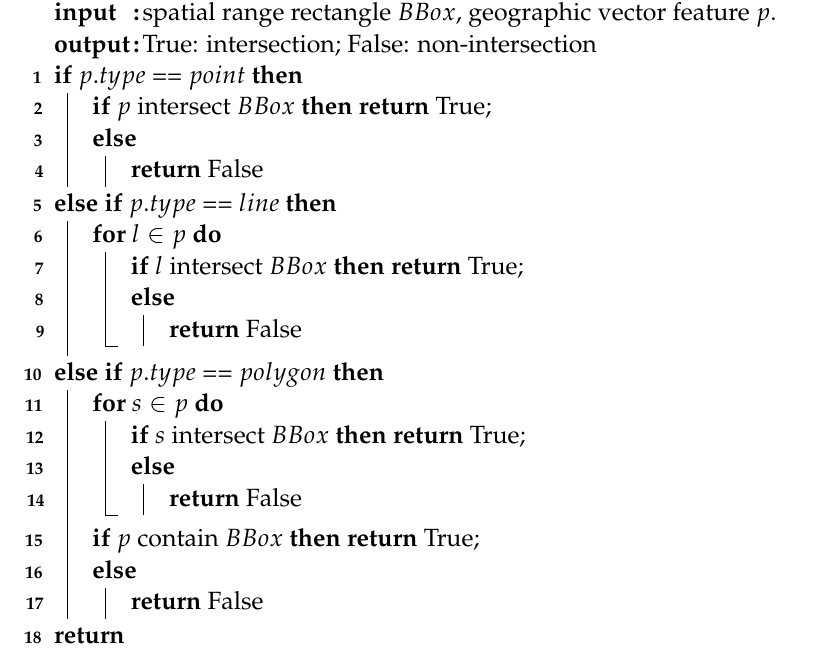
Algorithm 1: BBOXIntersectedGeometry: determine the intersection relationship between spatial range and geographic vector